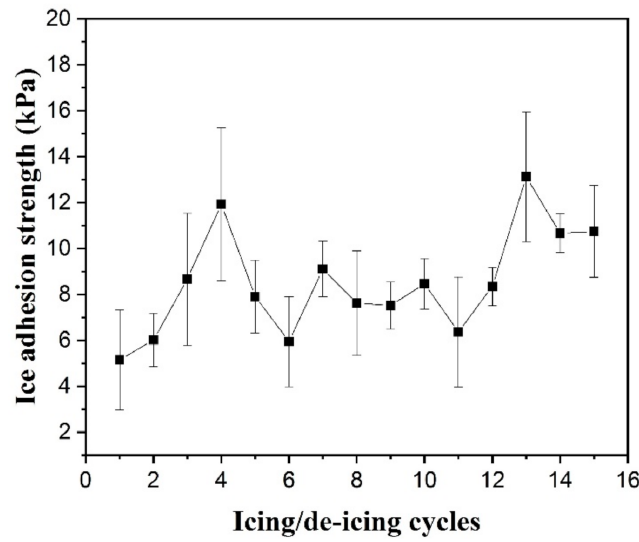
Figure 19. Ice adhesion change during icing/de-icing